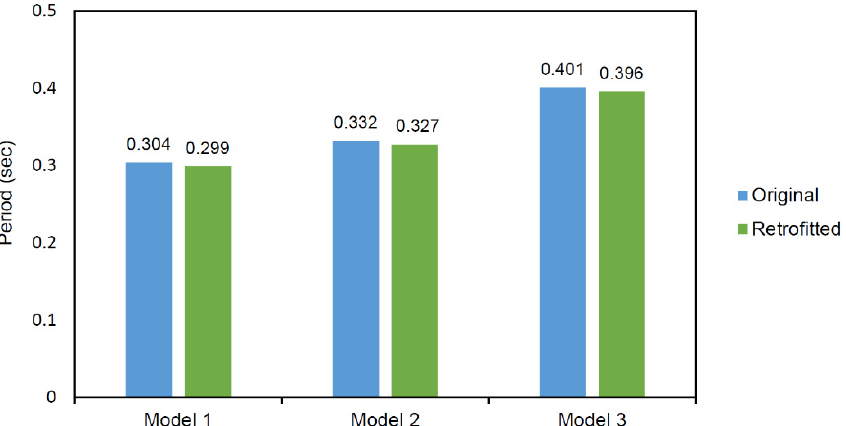
Figure 22. The e ff ect of cracking on the fundamental periods in the N–S direction for the original and retro fi tt ed structure (Cantilever